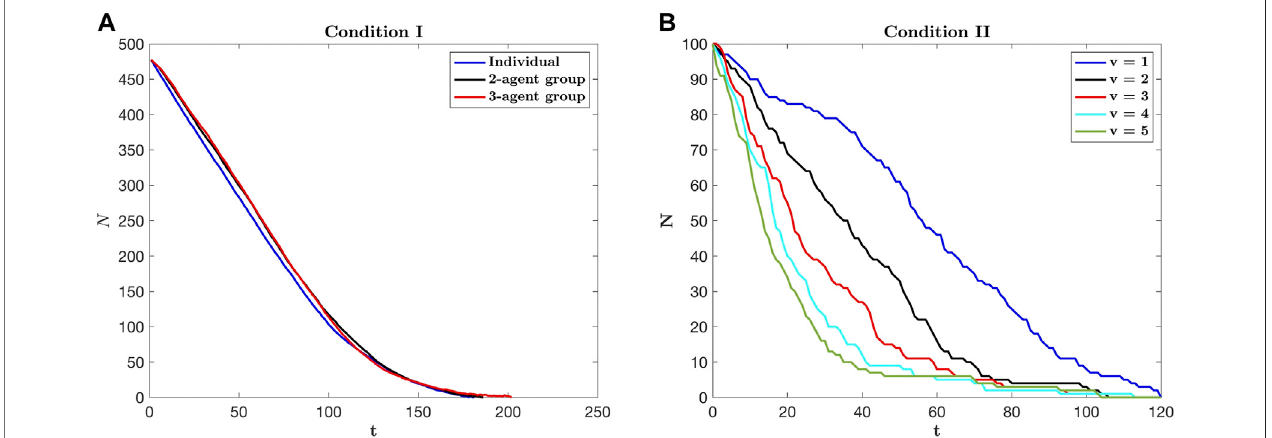
FIGURE 4 | Time evolution of the number of agents remained in the room in condition I (A) and II (B) .